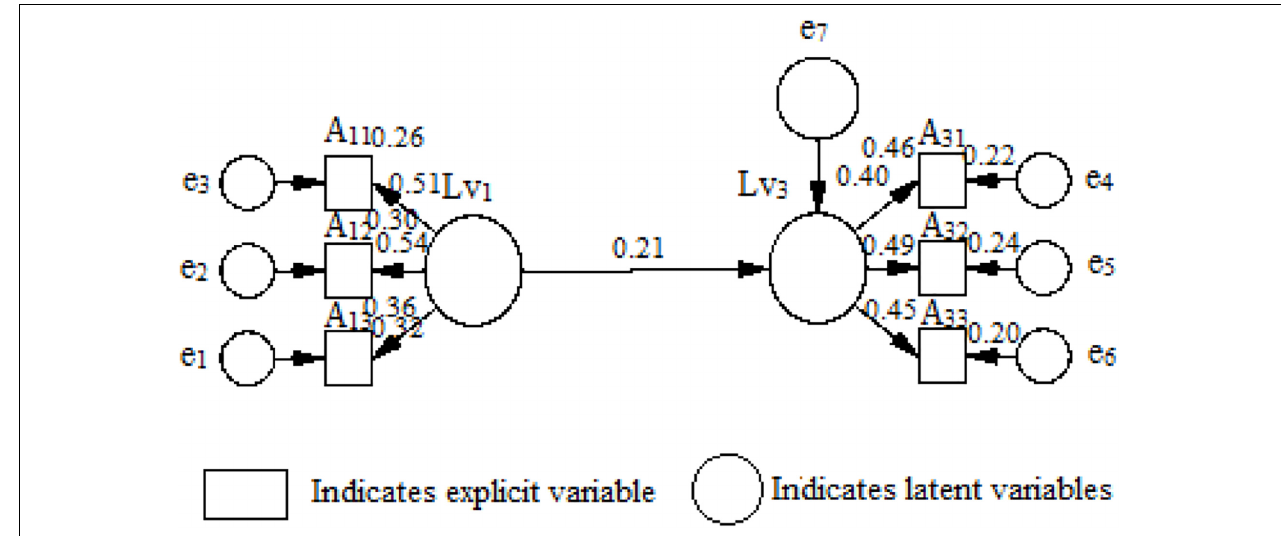
FIGURE 1 | Structural equation model of the impact of non-renewable energy development on regional economic